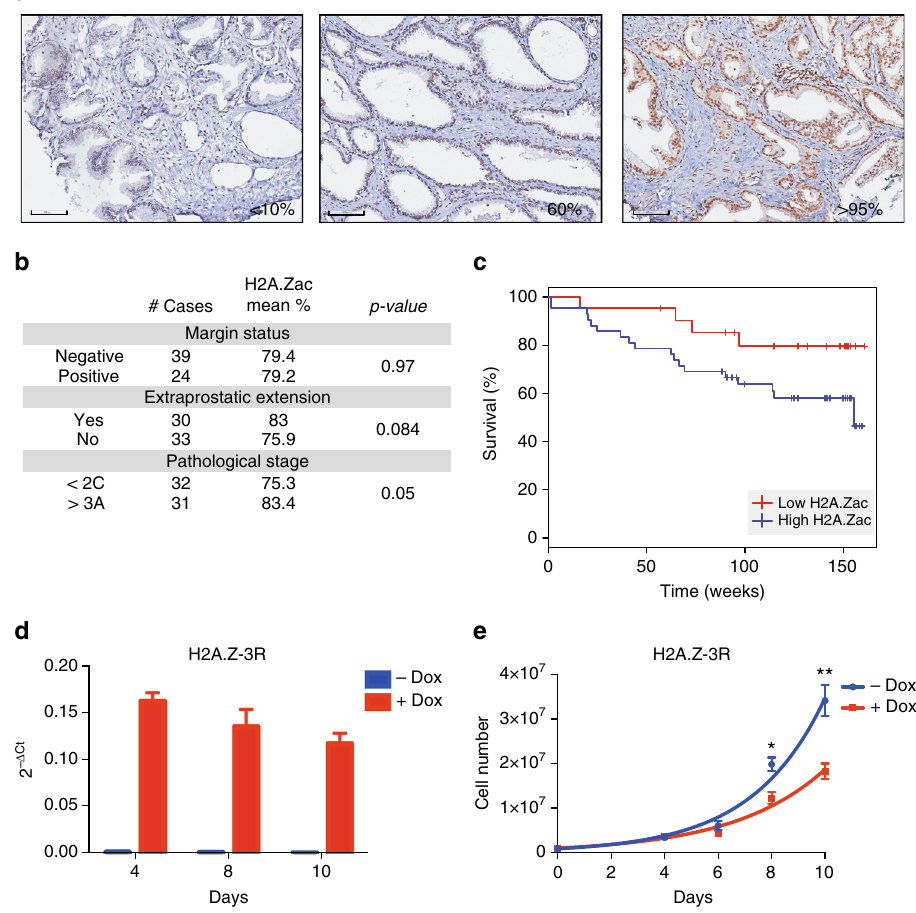
Fig. 1 H2A.Zac has pro-oncogenic characteristics in prostate cancer. a Immunohistochemical staining of tissue microarrays for H2A.Zac total protein. Tissue microarrays were stained with H2A.Zac speci fi c antibody (brown) and counterstained with hematoxylin (blue). Three representative tumor samples to show the scoring criteria used for differential H2A.Zac protein levels at × 20 magni fi cation (Aperio ImageScope sofware). Left hand site (LHS), low levels, 0 – 10%; middle panel, moderate (50 – 65%) and right hand site, (RHS), strong staining (95 – 100%). Scale bar = 100 μ m b Summary of the clinical parameters analyzed for H2A.Zac presence in 63 prostate tumor samples. Number of patients and mean value for H2A.Zac presence percentage are shown for each category. The associations between H2A.Zac status and discrete categorical variables were tested using the t-tests. c Kaplan-Meier plot of the survival analyses evaluating disease relapse was performed on the nuclear averaged H2A.Zac scores (Wald p -value = 0.044). The split into high and low was done on the basis of the median, H2A.Zac high (blue, >= 80%) and H2A.Zac low (red, < 80%). d Real-Time qPCR for the mRNA expression levels of 3R mutant form of H2A.Z in LNCaP cells over 10 days of daily Doxycycline (Dox) treatment. ( N > 3). Data was normalized using the 2 − Δ Ct method. Error bars are shown as s.d. e Cell proliferation curve of the 3 R cells over 10 days of Dox treatment. Alive cells were automatically counted ( N > 4) on days 4, 6, 8, and 10 (* t -test p- value < 0.05 and ** t -test p -value < 0.001). The graph showed is a representative example of three independent experiments. Error bars are shown as